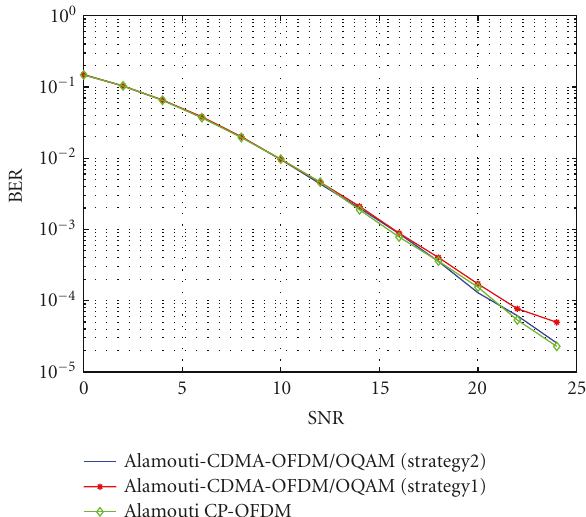
Figure 9: BER for two complex versions of the Alamouti CDMA- OFDM/OQAM with spreading in time domain, versus Alamouti CP-OFDM for transmission over the 4-path frequency selective channel.